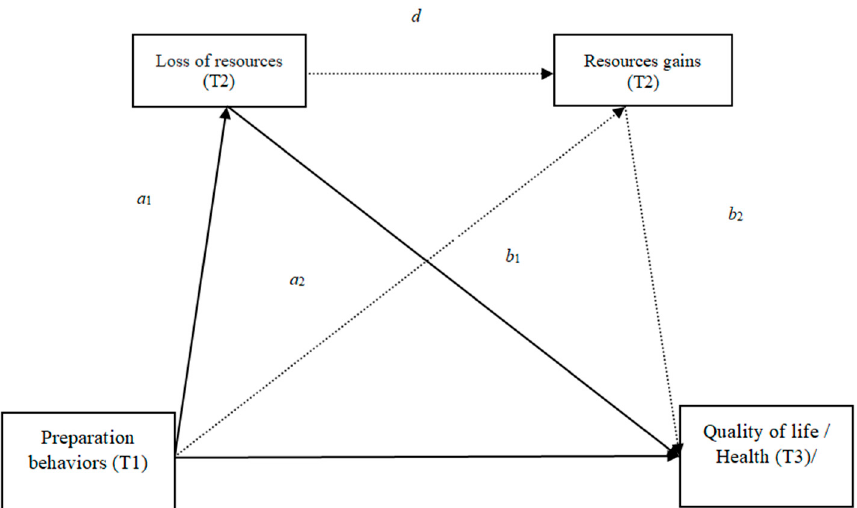
Figure 1. Visual representation of the study hypotheses. Hypothesis 1 (H1): Direct effect of the Behaviors of preparation in the Quality of Life (path c ′ ); Hypothesis 2 (H2): Direct effect of Health